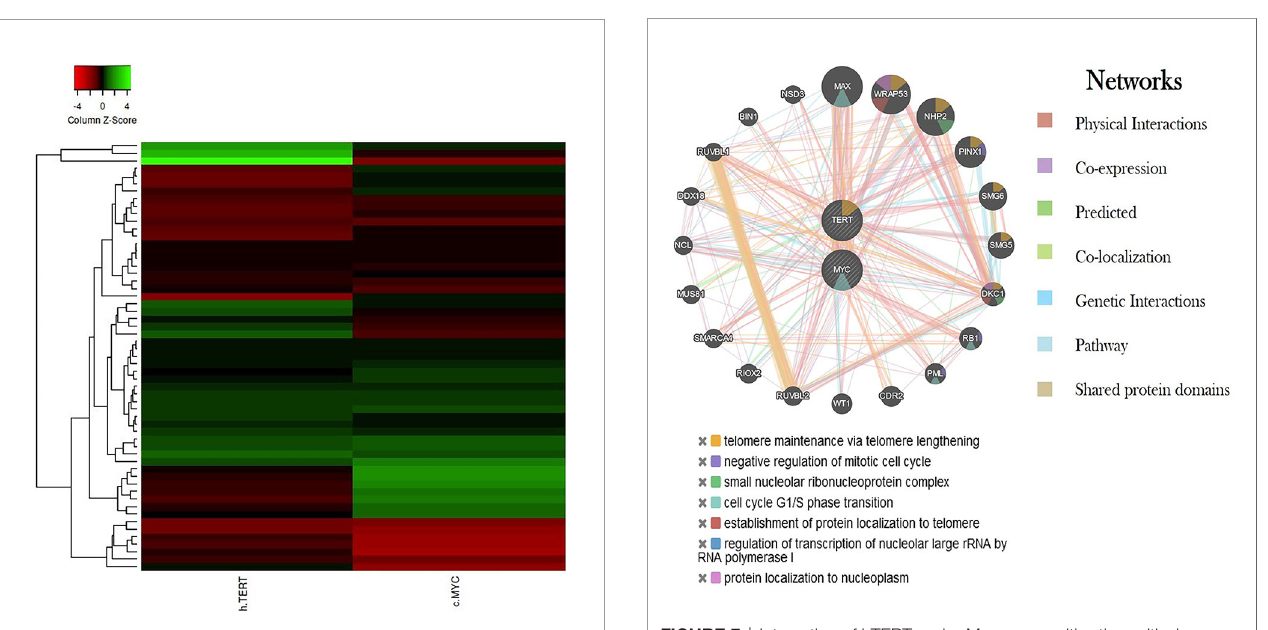
FIGURE 6 | The heat map plot of hTERT and c-Myc expression. Columns of the plot represent the genes and the rows represent samples, respectively.